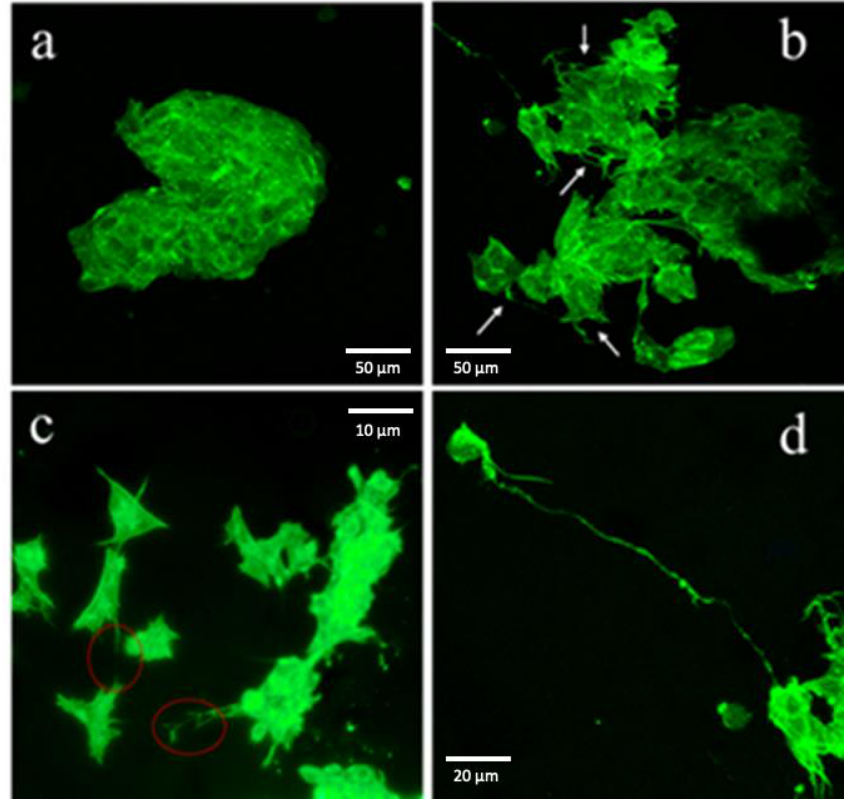
Figure 5. ( a ) Cells cultivated on pure NFC without differentiation factors maintained an immature phenotype, with cell aggregation and without presenting neurites. ( b ) Cells cultivated on conductive scaffold without differentiation factors presented a more neural phenotype, with cells that tend to stay separated and presenting many neurites. ( c ) Interaction between neural cells cultivated on conductive ink. ( d ) Very long neurite of a neural cell cultivated on conductive ink. Cells 2020 , 9 , x FOR PEER REVIEW 10 of 12